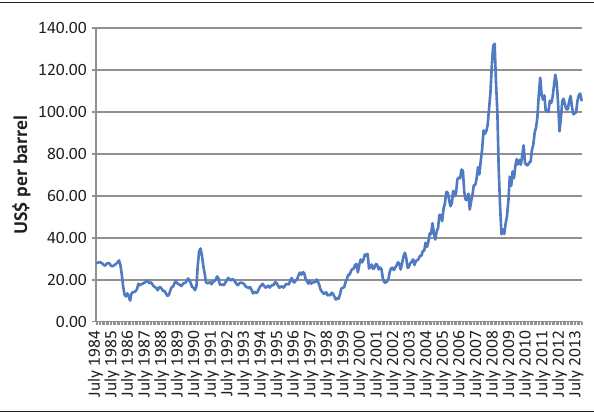
FIGURE 1: The trade-off between inventory and transportation costs in the United States.